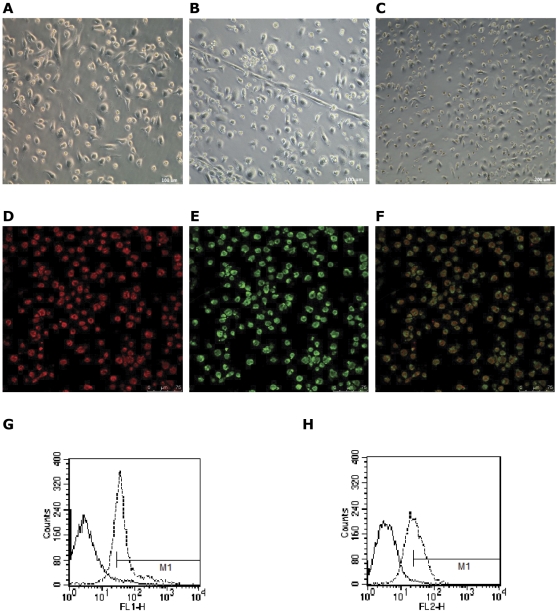
Spleen-derived MNCs differentiate into cells with characteristics of endothelial progenitor cells after cultured in vitro.(A) After 4–7days in culture, spleen-derived MNCs exhibited a spindle-shaped, endothelial cell-like morphology. Scale bar = 100 µm. (B) After 10 days, cells formed cord-like structures. Scale bar = 100 µm. (C) After 20 days, cells became confluent, and looked like cobblestones. Scale bar = 200 µm. (D,E,F) Spleen-derived MNCs showed uptake of acetylated LDL (D) and UEA-1 binding (E) after 4 days in culture. Most adherent cells were LDL and UEA-1 double positive (91.2±1.8%; n = 5; three random fields per well). Scale bar = 75 µm. (G) FACS analysis of cultured spleen-derived MNCs for FITC-Sca-1 (a stem/progenitor cell marker), generating a positive rate of 71.7±0.93% (n = 3). (H) FACS analysis of cultured spleen-derived MNCs for PE-VEGFR-2 (an endothelial cell marker), generating a positive rate of 52.49±9.27% (n = 3). The left peak in each box denotes corresponding negative isotype control labeling, and the positive gate M1 is shown.